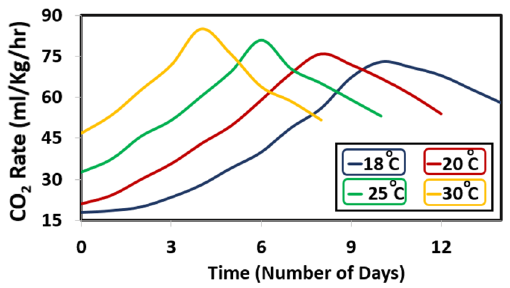
Fig. 3 Variation of CO rate over time under storage temperatures 2 of 18 °C, 20 °C, 25 °C and 30